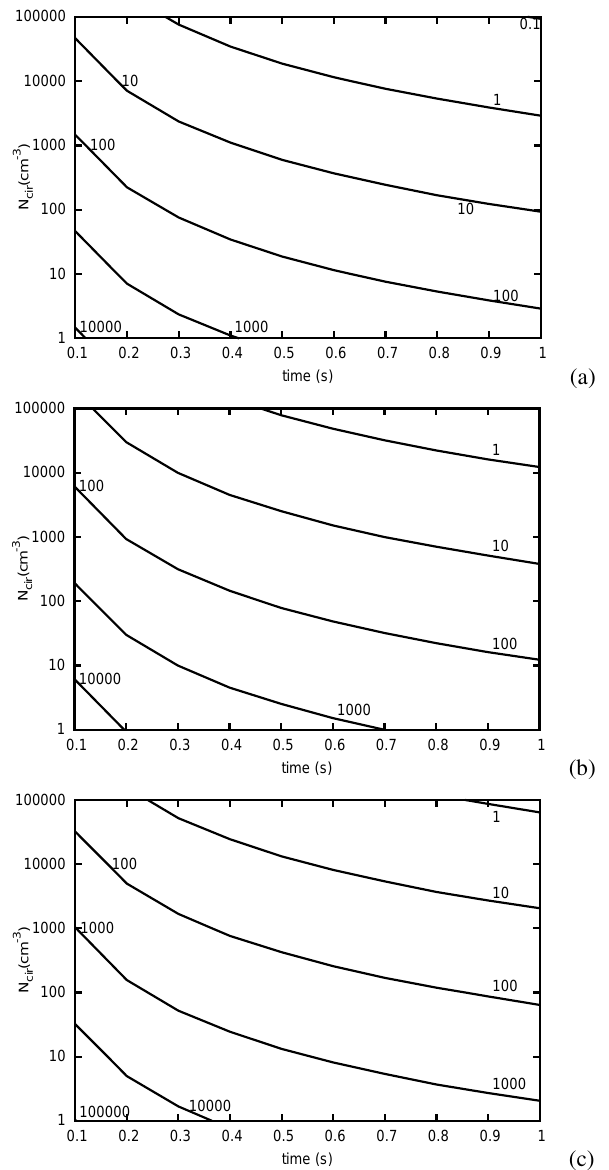
Fig. 1. Isolines of τ cond / τ jet , the ratio of the condensation time scale to the jet expansion time scale vs. plume age during contrail formation (first second) and vs. number concentration of ice crys- tals in the ambient cirrus for various conditions: (a) T = − 40 ◦ C, p = 300hPa, (b) T = − 50 ◦ C, p = 250hPa, (c) T = − 60 ◦ C, p = 200hPa. Note that crystal number concentrations for cirrus clouds exceeding 10cm − 3 are unrealistic. On the contrary, number con- centrations in young contrails are of the order 10 4 to 10 5 cm − 3 . Hence, contrail formation within a cirrus cloud is generally not af- fected by the cirrus ice crystals (ratio (cid:29) 1) but the ice crystals form- ing and growing in the exhaust can affect the evolution of the super- saturation almost as strongly as the expansion process does.